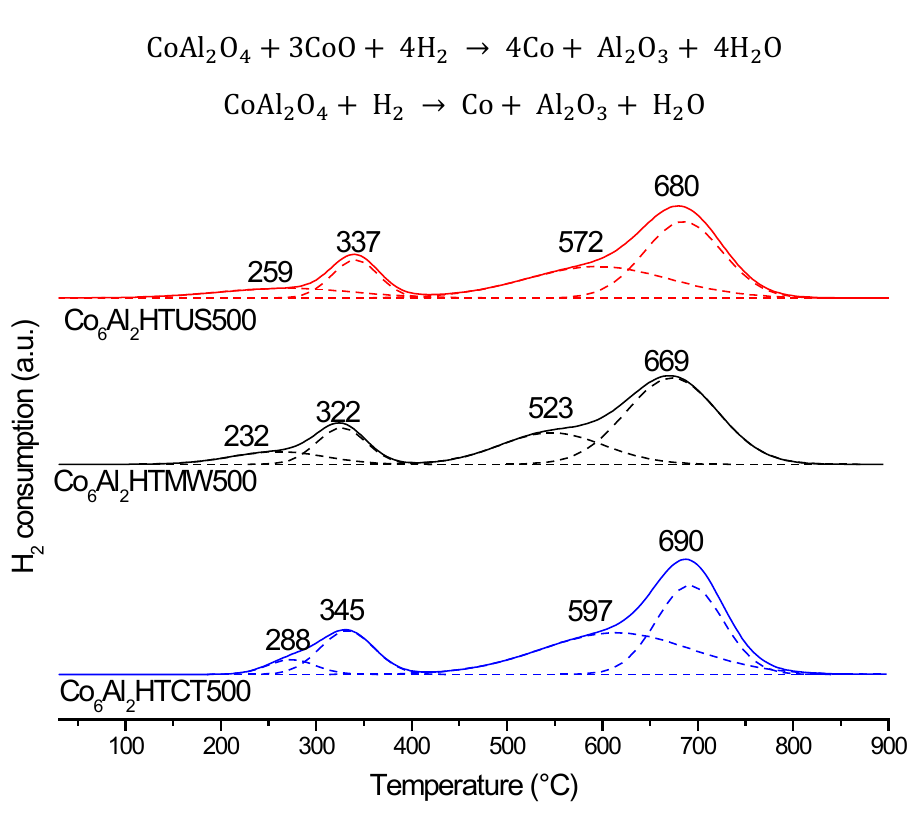
Figure 4. H 2 -TPR profiles of the mixed